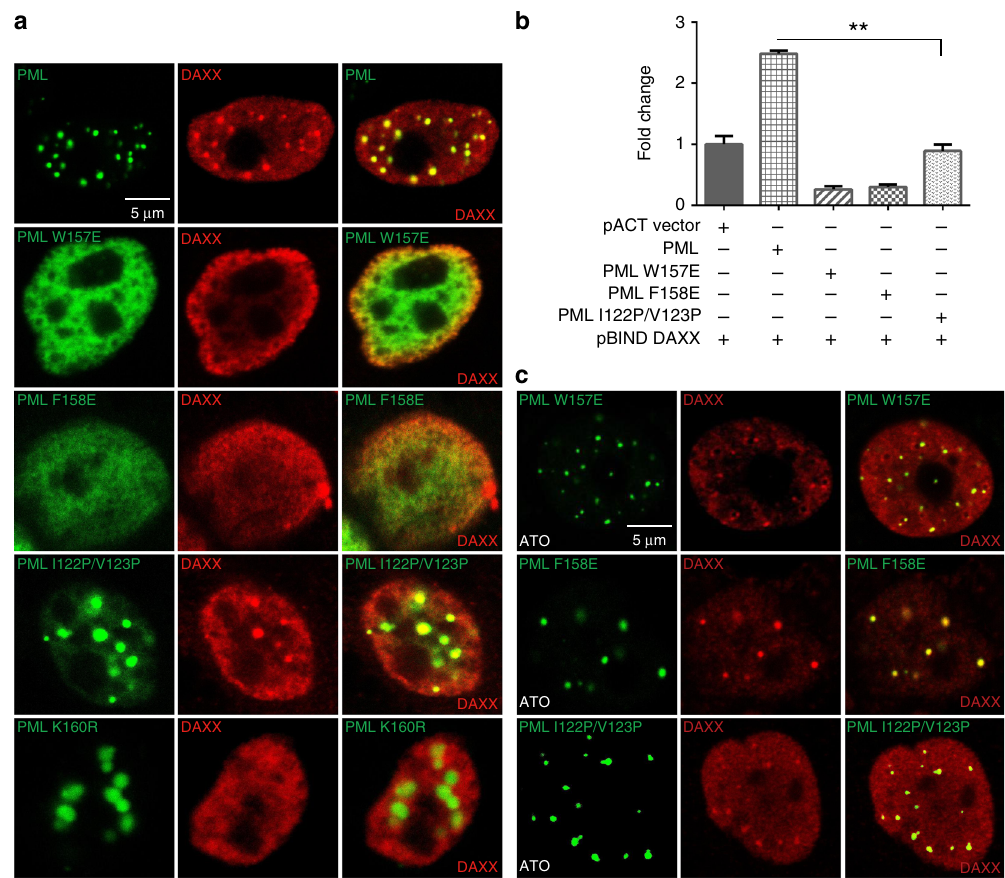
Fig. 6 Immuno co-localizations of PML and partner proteins. a Immuno co-localization between PML isoform IV and DAXX. The expressions of GFP-PML and mutants were visualized by immuno fl uorescence. Scar bar is 5 μ m. The expressions of DAXX were detected using antibody against FLAG tag. In addition to the newly reported B1 mutations, the K160R mutant, which impairs the PML sumoylation 24 , was also monitored. b Mammalian two-hybrid characterization between PML isoform IV and DAXX. The interactions between WT/mutants and DAXX are all normalized against the pACT vector: pBIND-DAXX interaction ( = 1). Values are means± S.E. ** p < 0.01. Source data are provided as a Source Data fi le. c NB-enhanced partners recruitment